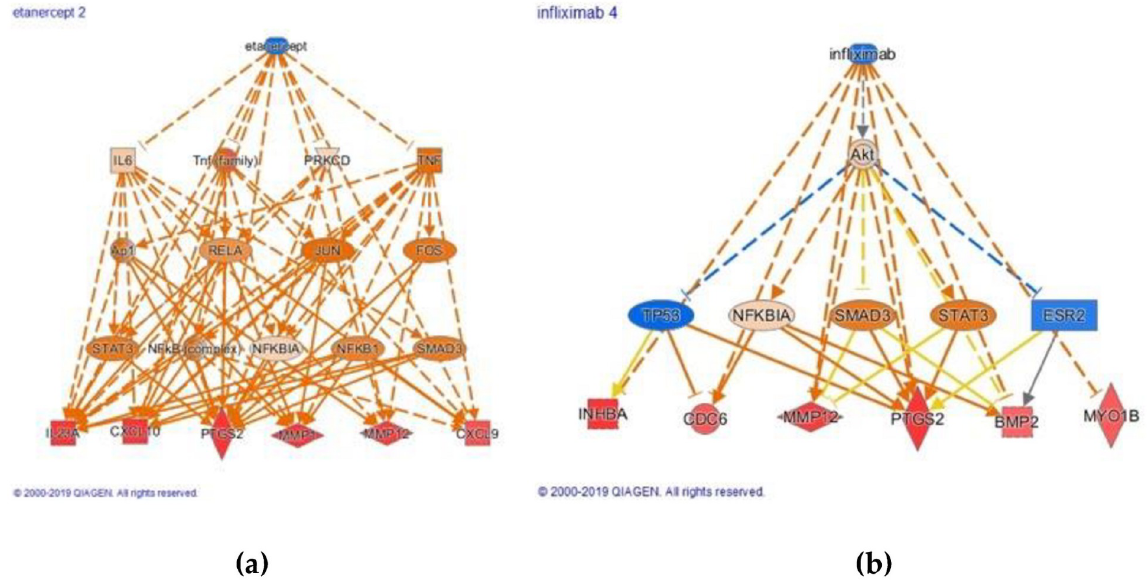
Fig 3. a-b. IPA analysis and mapping of Etanercept (a) and Infliximab (b).